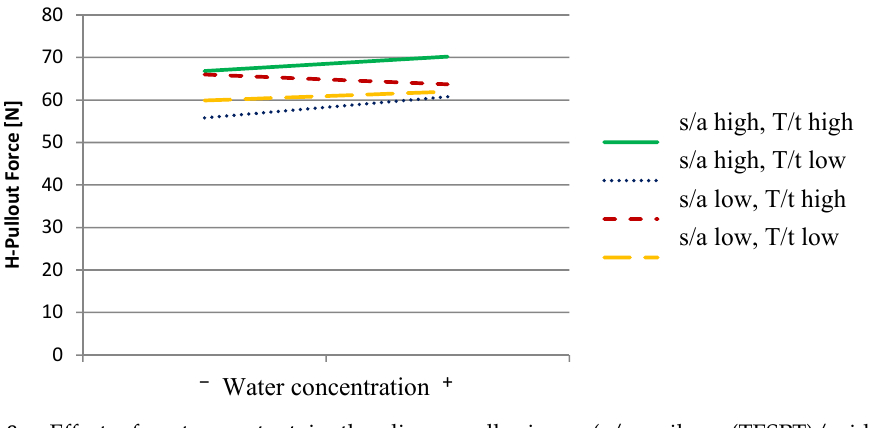
Figure 8. Effect of water content in the dip on adhesion. (s/a: silane (TESPT)/acid, T/t: temperature/time).